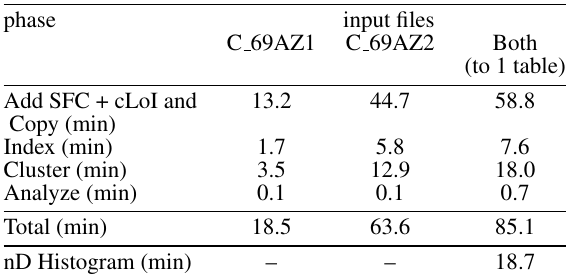
Table 2. Preparing the database structure (table and index) with SFC and cLoI added per point.